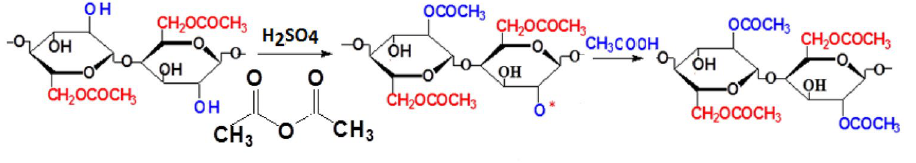
Figure 3. A Reaction mechanism to obtain a cellulose diacetate (CDA) from